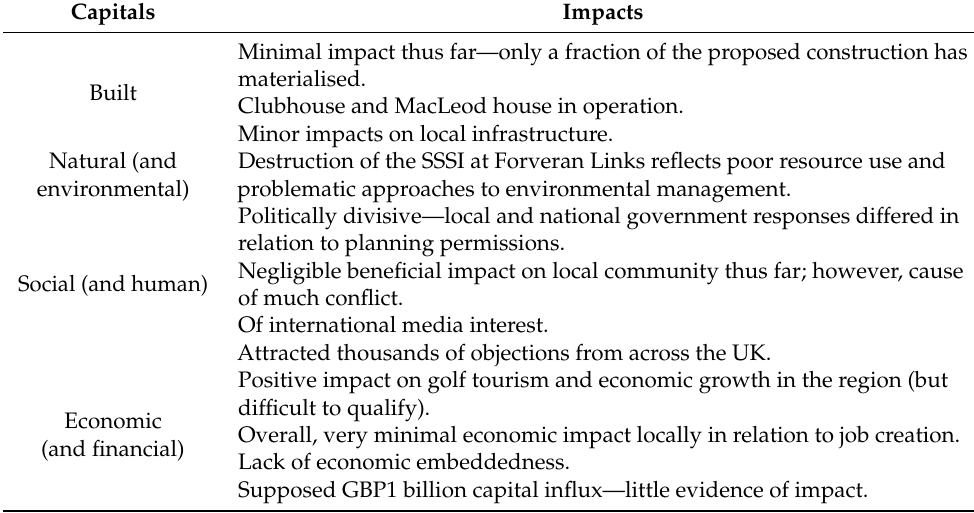
Table 3. Capitals, change variables, and their interpretation: